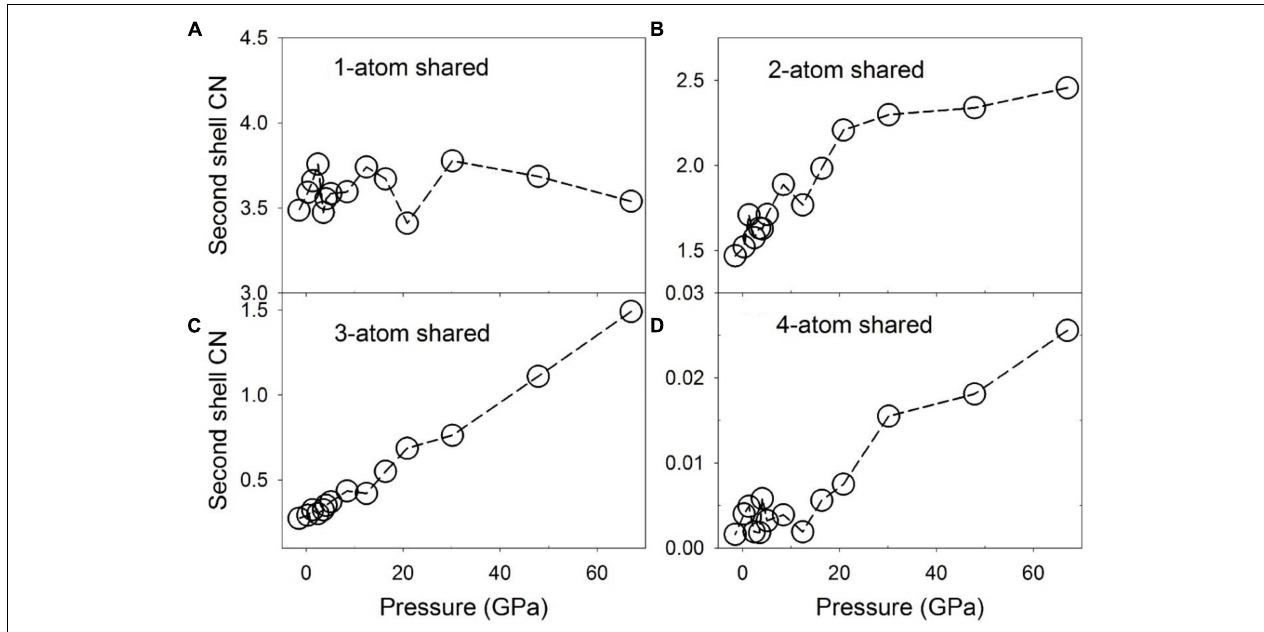
FIGURE 8 | Coordination numbers (CNs) of C-Fe/Ni polyhedra associated with partial configurationally decomposed PDFs as a function of pressure. (A) 1-atom corner-shared, (B) 2-atom edge-shared, (C) 3-atom face-shared, and (D) 4-atom shared connections.